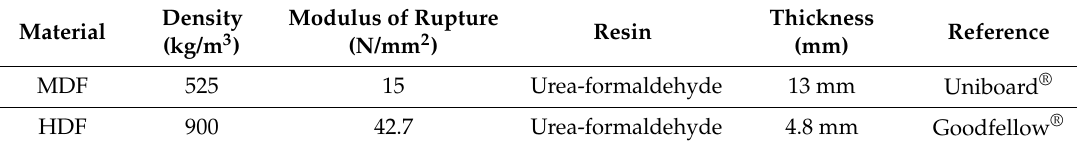
Table 1. Properties of wood panels as provided by the suppliers.